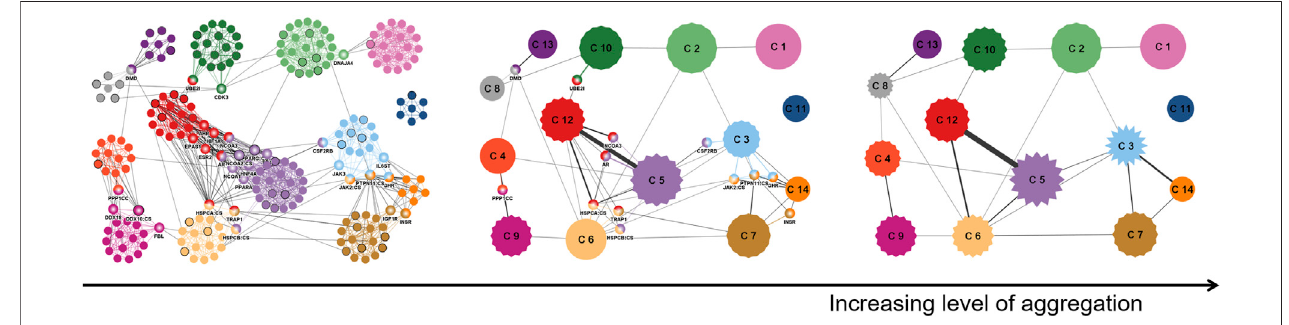
FIGURE 8 | Visualization of data of a protein – protein interaction network (Jonsson and Bates, 2006). The images show the same subnetwork as in the original article, containing 1,253 weighted interactions between 232 proteins, where edge weights indicate con fi dence scores for the interactions. From left to right: increasing level of aggregation, starting from the original network data. Image: © 2013 IEEE. Reprinted, with permission, from Vehlow et al. (2013).